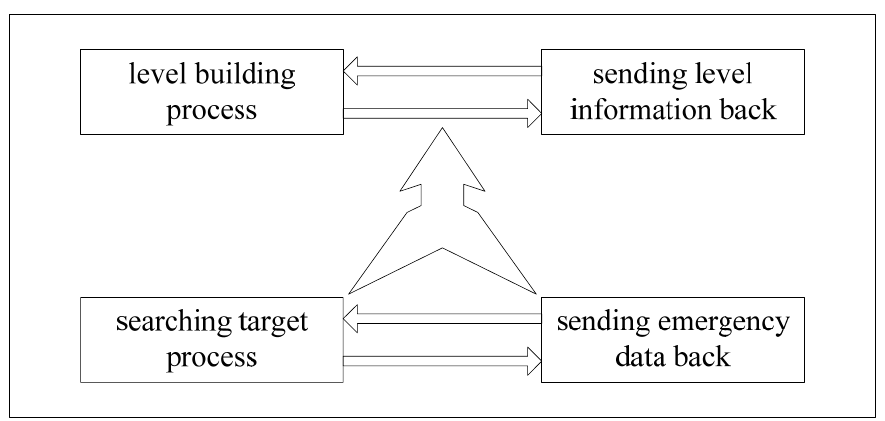
Figure 6. Architecture design of